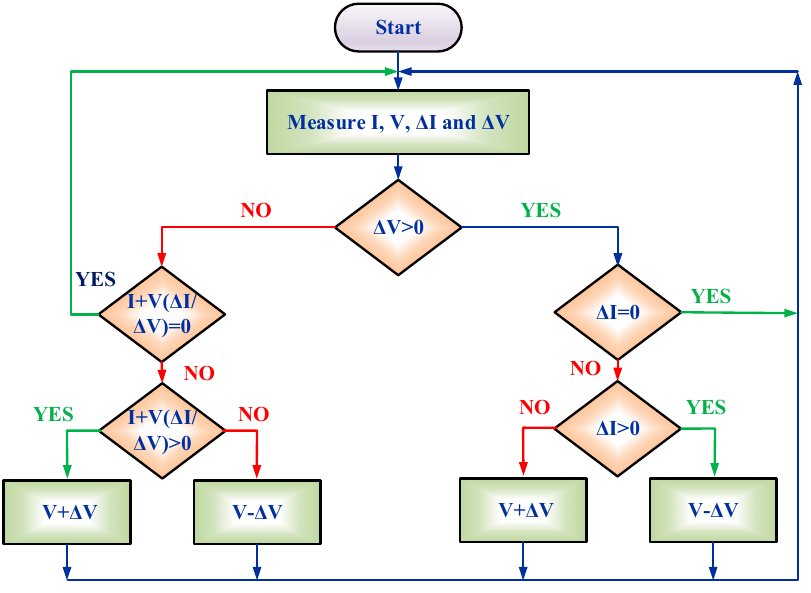
Figure 6. Flowchart of incremental conductance (INC) method.